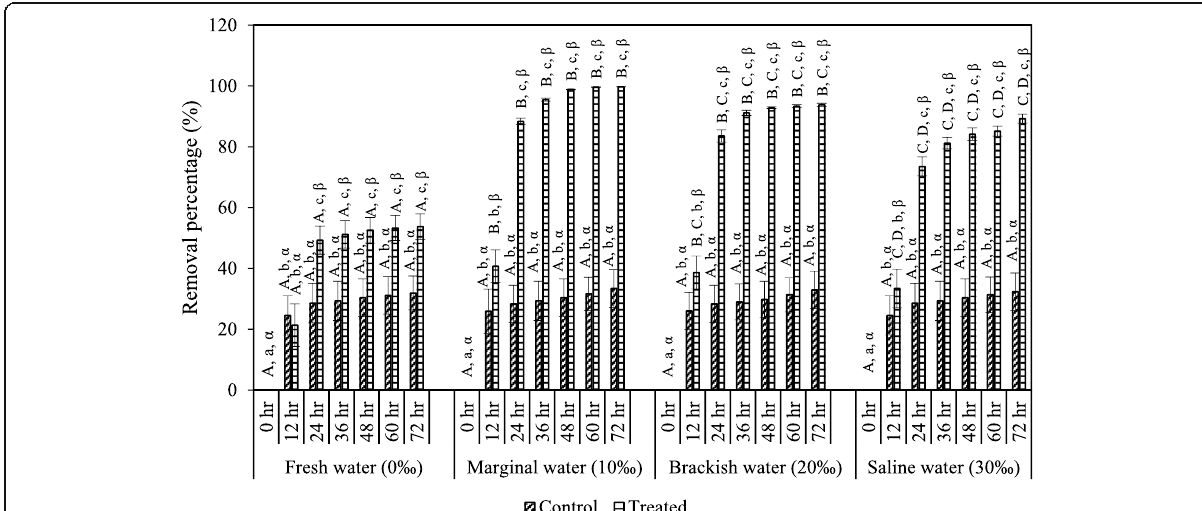
Fig. 3 Removal of Hg by P. aeruginosa FZ-2 at different salinity levels. The error bar indicates the standard deviation with three replicates. The A- B-C symbols show significant differences at p < 0.05 at different salinity levels for the same contact times. The a-b-c symbols present significant differences at p < 0.05 for various contact times at the same salinity level. The α - β symbols show significant differences at p < 0.05 between the control and treated